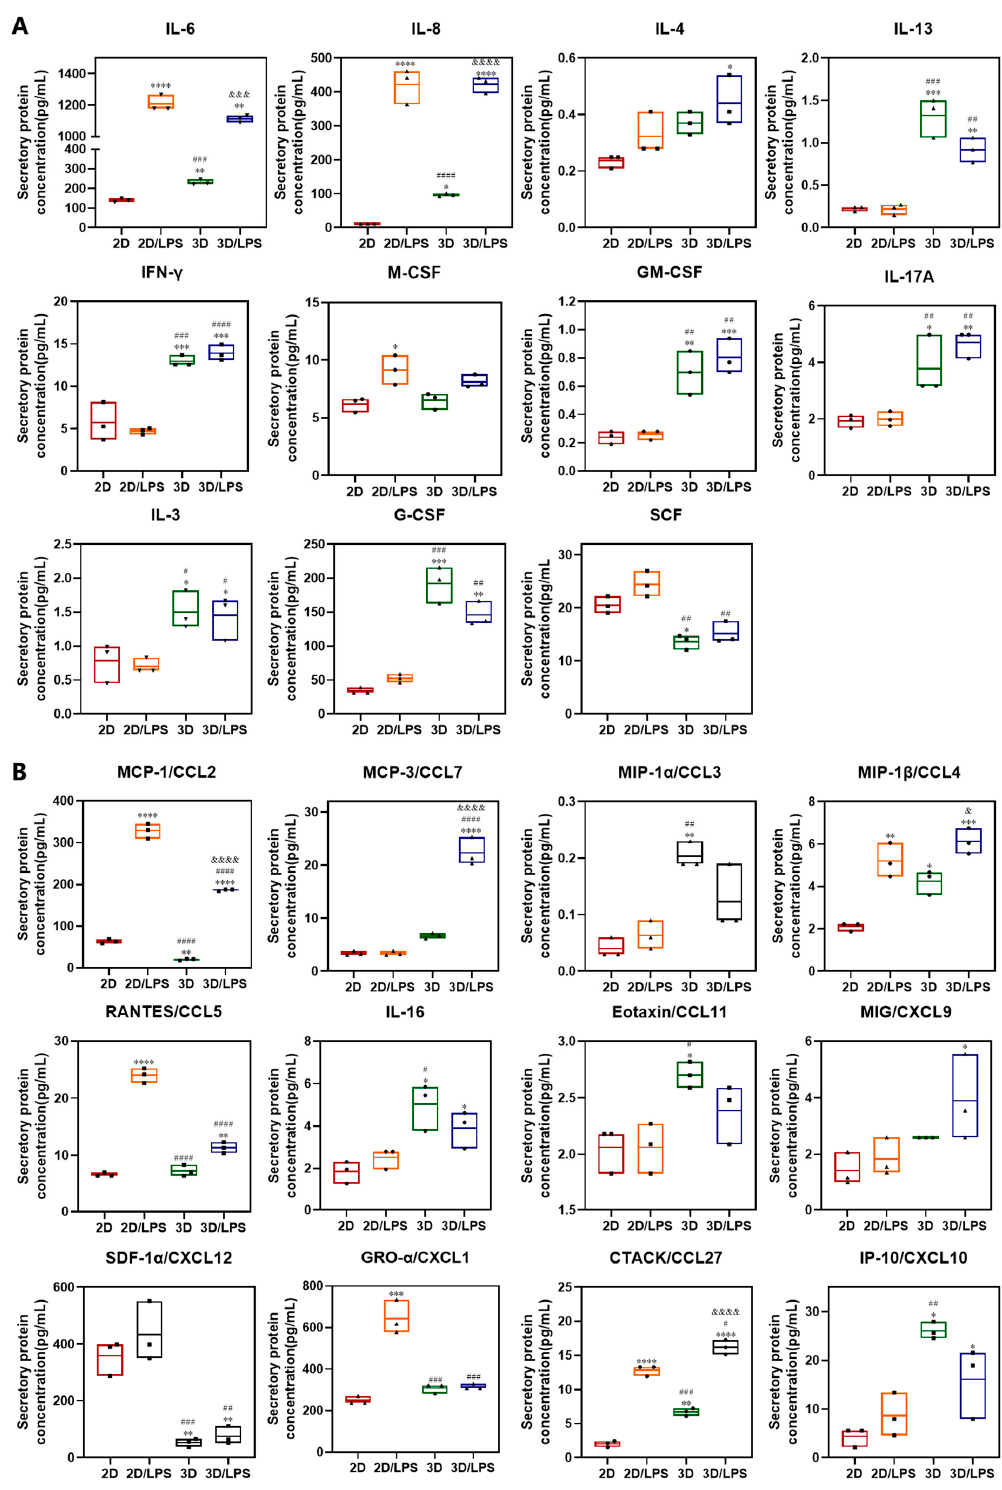
Figure 8. Immune cytokine assay of PDLSC-derived secretome after LPS and/or 3D culture treatment. ( A ) Cytokine expression involved in macrophage polarization and differentiation in 2D-, 2D/LPS-, 3D- and 3D/LPS-group-derived secretome; ( B ) Chemokine expression in 2D-, 2D/LPS-, 3D- and 3D/LPS-group-derived secretome. * p < 0.05, ** p < 0.01, *** p < 0.001, **** p < 0.0001, compared with 2D group; # p < 0.05, ## p < 0.01, ### p < 0.001, #### p < 0.0001, compared with 2D/LPS group; & p < 0.05, &&& p < 0.001, &&&& p < 0.0001, compared with 3D